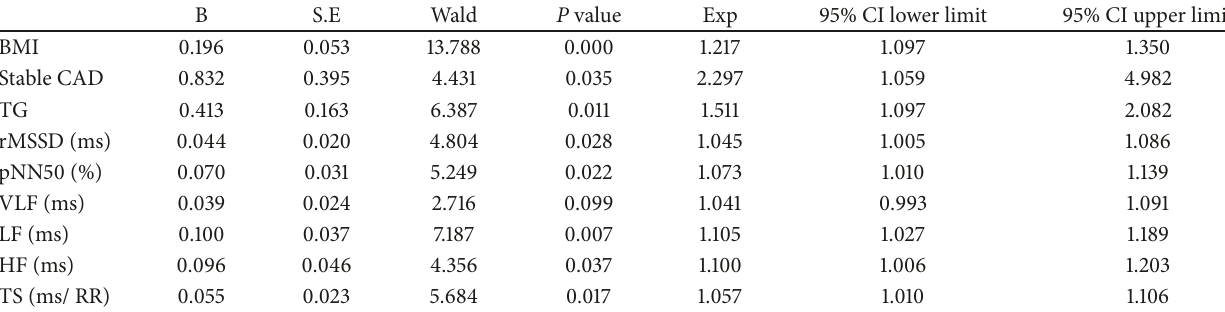
Table 2: Multivariate logistic regression results for risk of